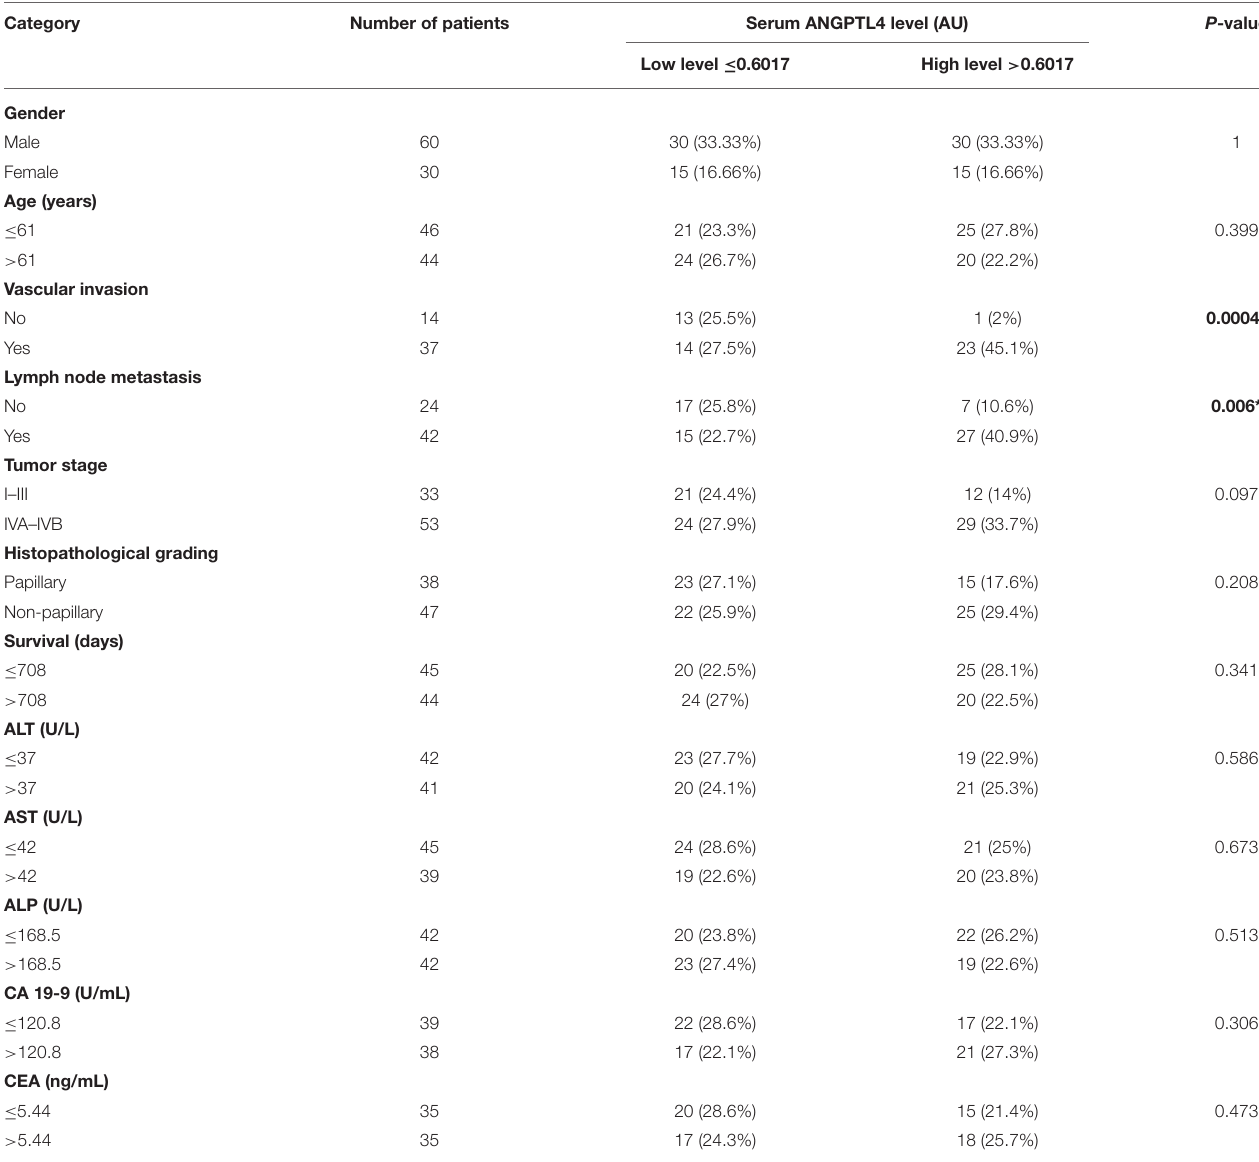
TABLE 2 | Association between serum ANGPTL4 level and clinicopathological parameters in CCA patients.